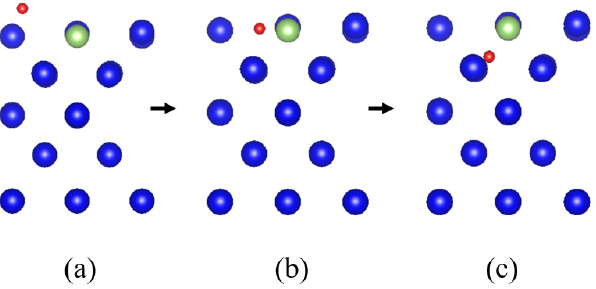
Figure 10. Intermediate state of diffusion process: ( a ) image1, ( b ) image3, ( c ) image5.